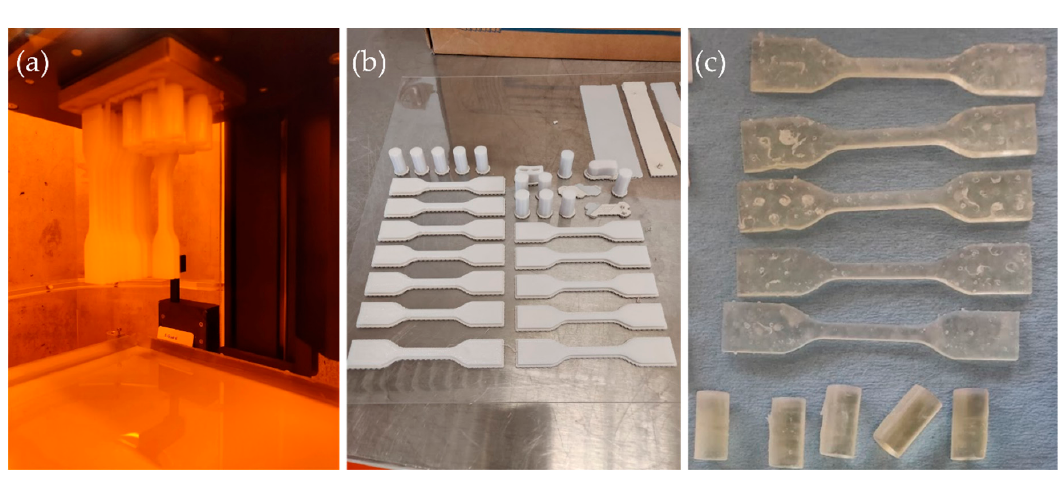
Figure 2. Example of specimens manufactured with ( a ) DLP, ( b ) FDM, and ( c ) SLA technologies.